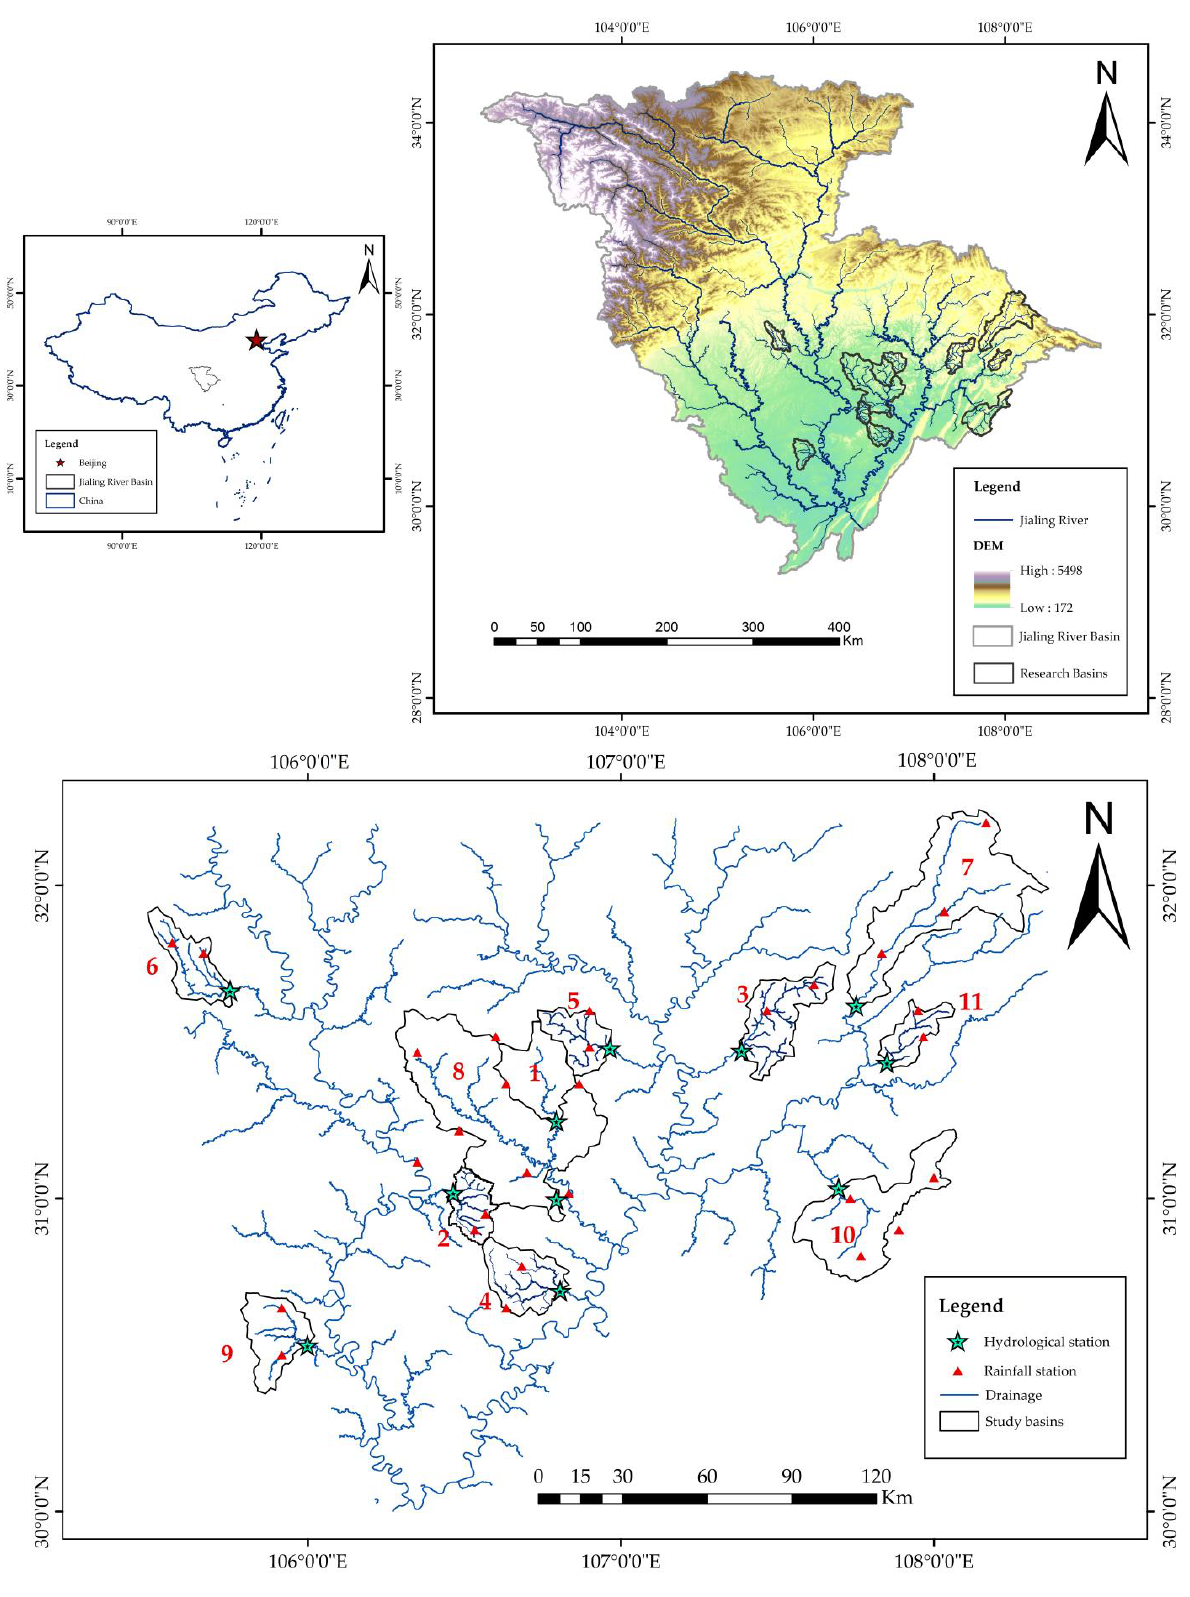
Figure 1. Location, ground observation, and DEM of the 11 catchments in the study area. Abbreviations and the identification number for each study basin: Shuixiazi is SXZ (ID1); Boyang is BY (ID2); Yonghong is YH (ID3); Changtanqiao is CTQ (ID4); Yuantuo is YT(ID5); Hongyan is HY(ID6); Maoba is MB (ID7); Jingbian is JB (ID8); Zhaojiaci is ZJC (ID9); Mingyuetan is MYT (ID10); Qingxi is QX (ID11).